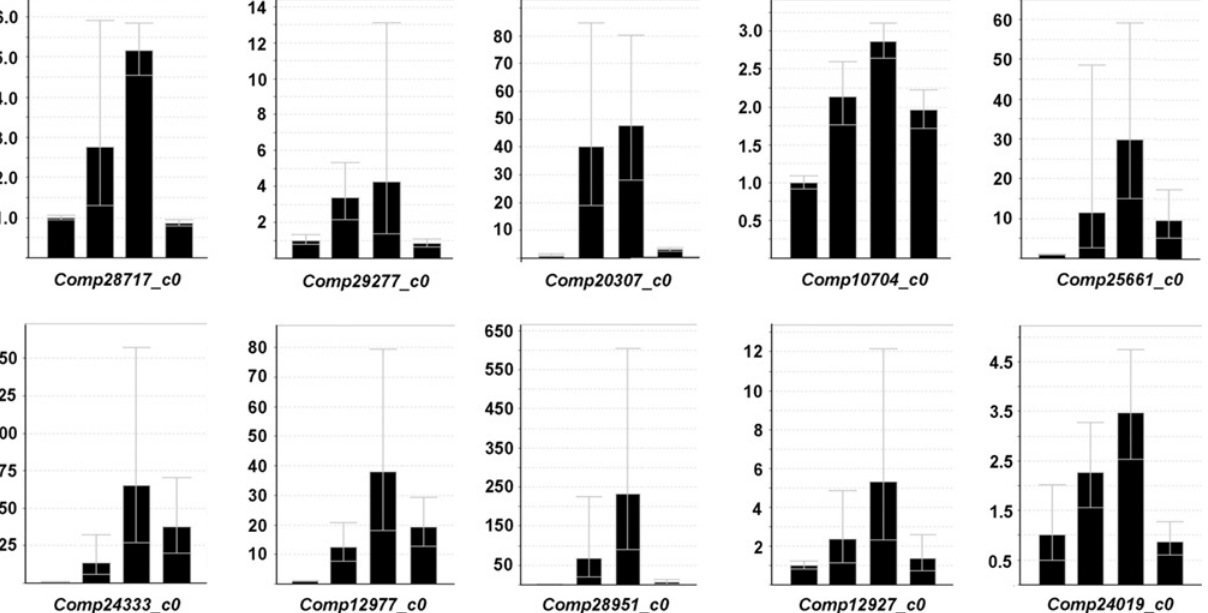
Fig 12. Validation of the DEGs by RT-qPCR. The relative expression levels of ten unigenes, which exhibited the ‘ up-up-down ’ expression pattern in the course of 24h of water stress following 6h of rehydration, were calculated with the 2 – ΔΔ CT method. The actin gene was used as an internal control. For each tested unigene, the columns from left to right represented its relative expressive levels in P-0h, P-6h, P-24h and Rh-6h, respectively. Error bars indicated the standard deviation of the mean expression